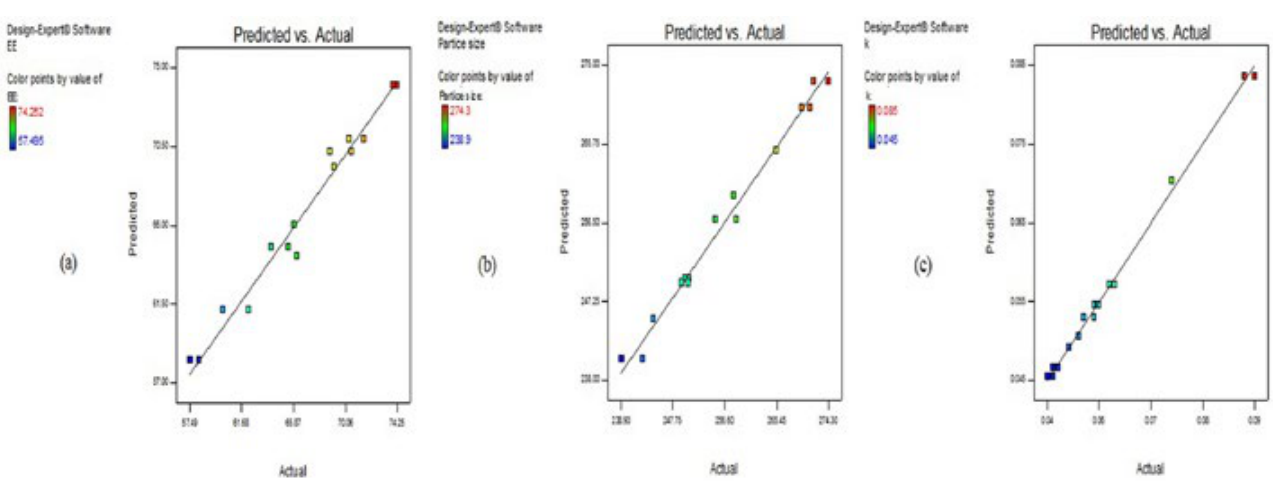
FIGURE 5 - Predicted versus actual plots for the responses (a) particle size; (b) entrapment efficiency; (c) drug release rate